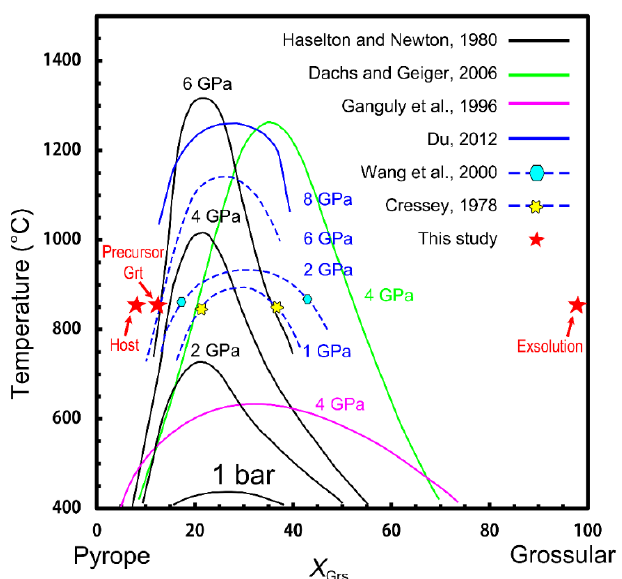
Figure 9. Phase diagram of pyrope–grossular binary versus pressure–temperature condition based on the different thermodynamic models (modified after Du [8]).